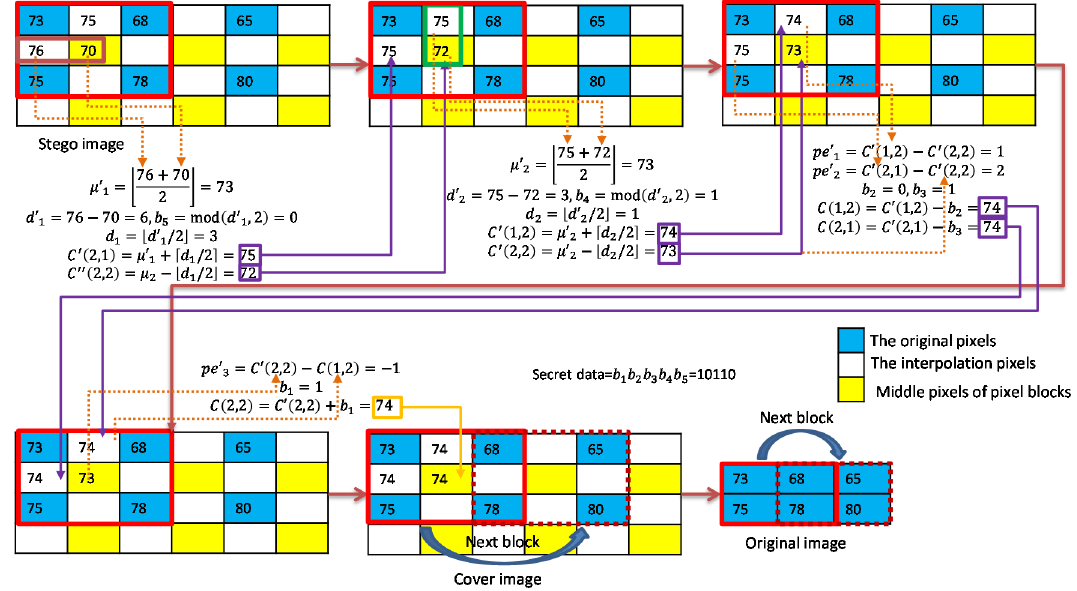
Figure 6. Example of interpolation and data embedding for complex blocks.